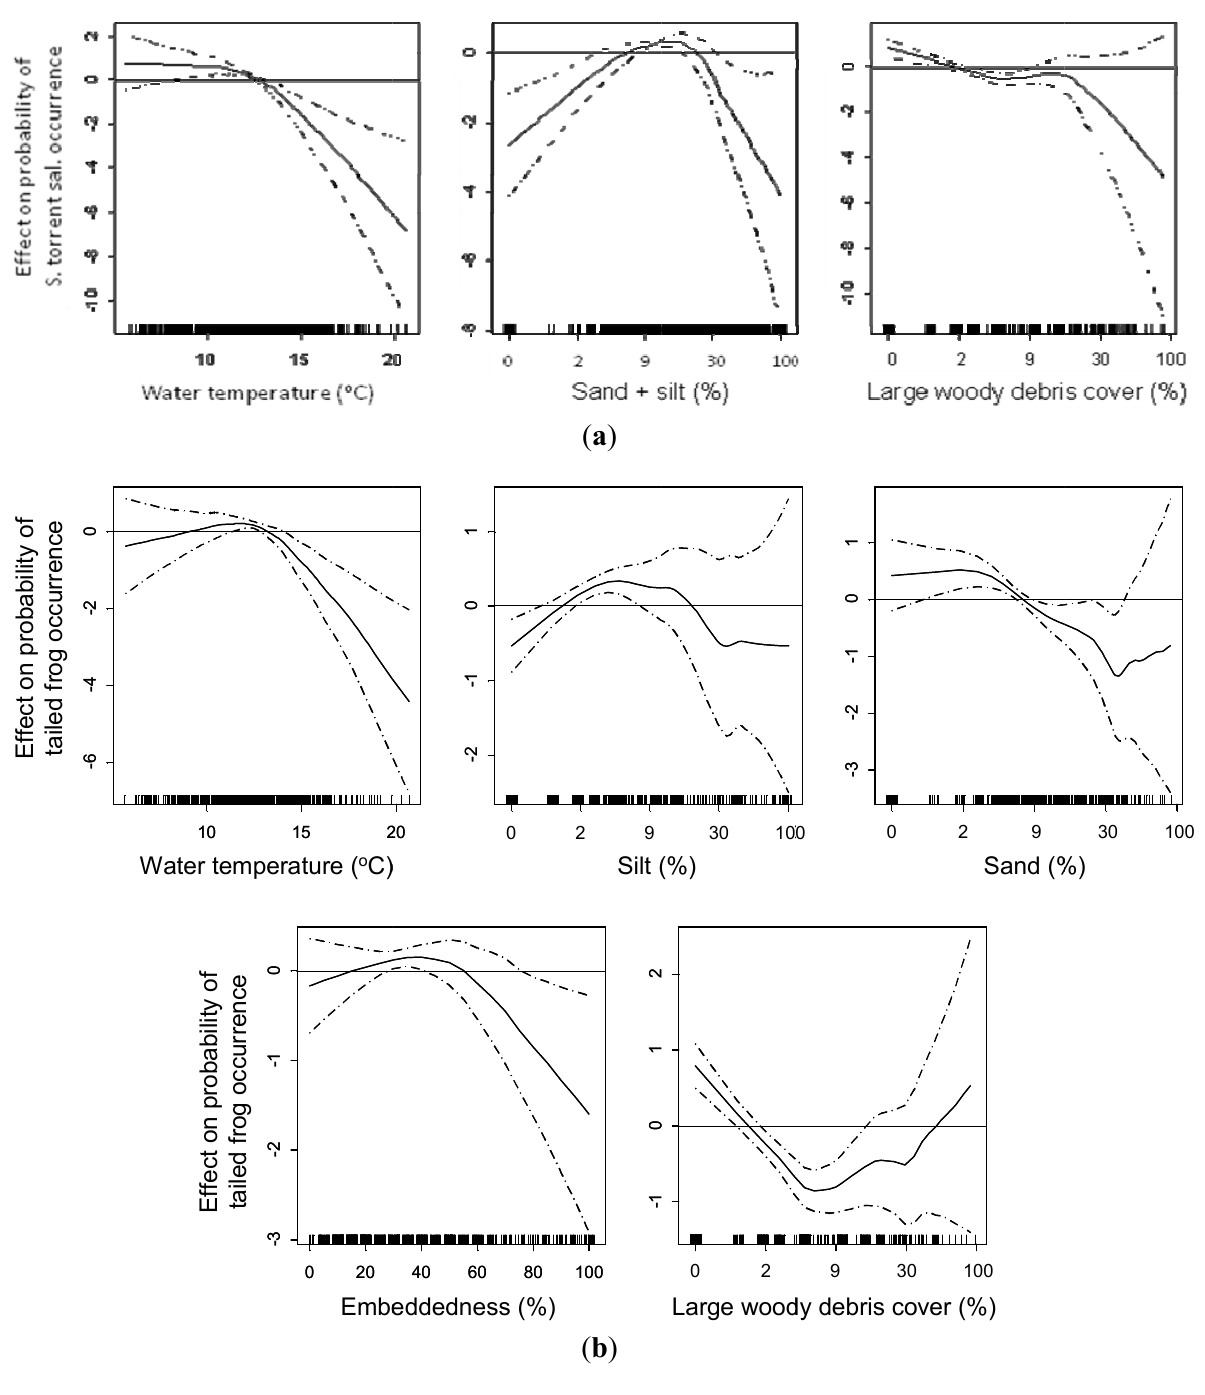
Figure e of the estim mated nonp parametric f function (so interva lines) for t the best pre edictive mo odel (GAM) salama ander; ( b ) th he larval ta ailed frog; a and ( c ) the c coastal gian form describes the relation nship of e each indepe endent var salama ander or lar rval frog pr resence give en the inclu usion of Model l thresholds s are indica ated by thos se points w ks on the x- -axis repres sent variable (from Wels